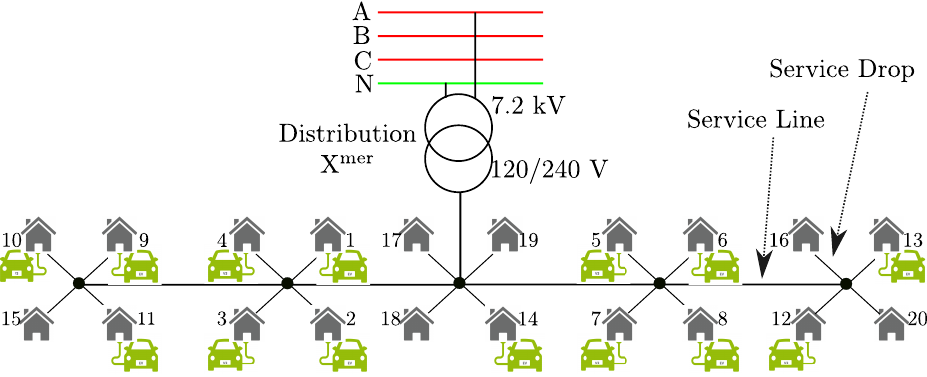
Figure 1. Schematic of secondary distribution system used for this